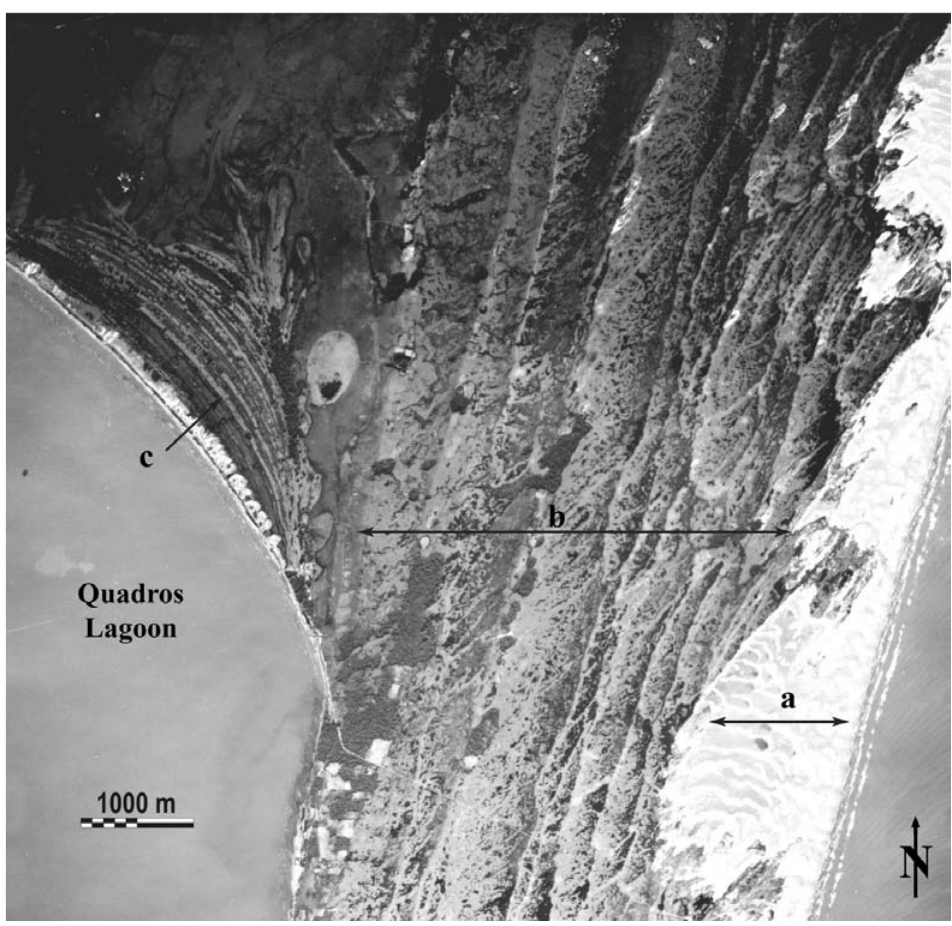
Fig. 4 – The Holocene transgressive dunefield prograded barrier system at Curumim, ∼ 150 km NE of Porto Alegre. The seaward portion is an active transgressive dunefield (a), while the vegetated portion consists of many overlapping, low, vegetated transgressive dunefields (b). This barrier has been interpreted in the past as a ‘beach ridge plain’ but the ridge lines are actually precipitation ridges and the terminal margins of dunefields marking the downwind edge of each dune phase. Many ridges on the seaward half of the barrier are lobate and not laterally continuous, and have been eroded, or terminated by wash-outs (sangradouros). The spacing between ridges is hundreds of meters, far greater than that observed for foredunes or beach ridges ( sensu stricto ). In contrast, note the scale, ridge spacing and plan shape of the beach ridges and foredunes which occur on the northeastern margin of the Quadros Lagoon at Arroio Cornelius